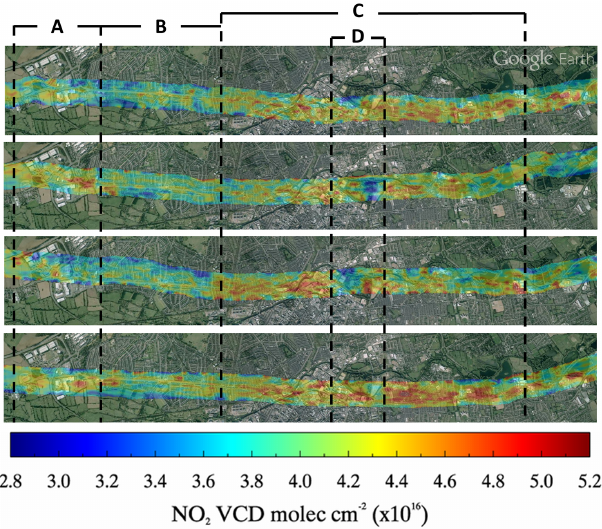
Figure 15. Google Earth overlay of the repeat NO 2 measurements over Narborough road and the A6 moving through time from top to bottom. Each point on adjacent transects is approximately 6min apart. Coordinates for the region are provided as region 1 in Table 5.